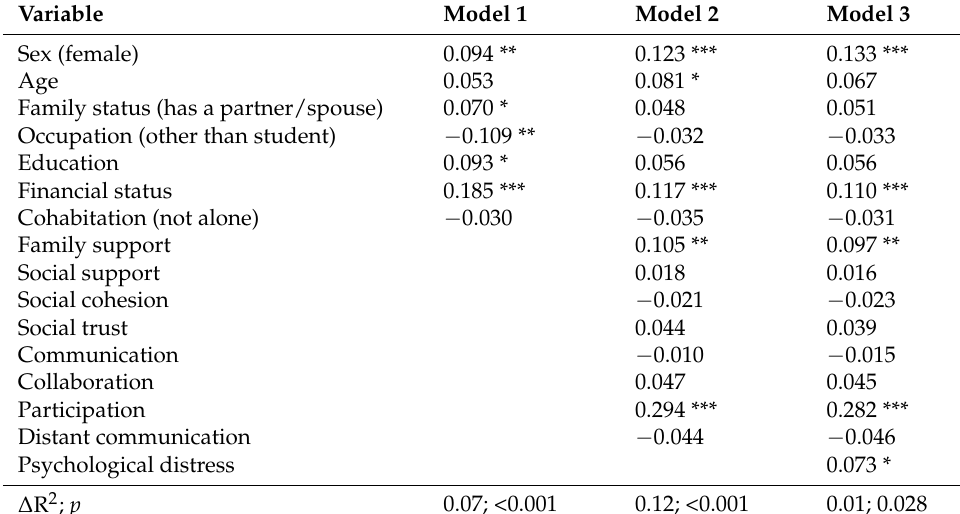
Table 3. Prediction of adherence to the Mediterranean diet from sociodemographic, social capital, and psychological distress